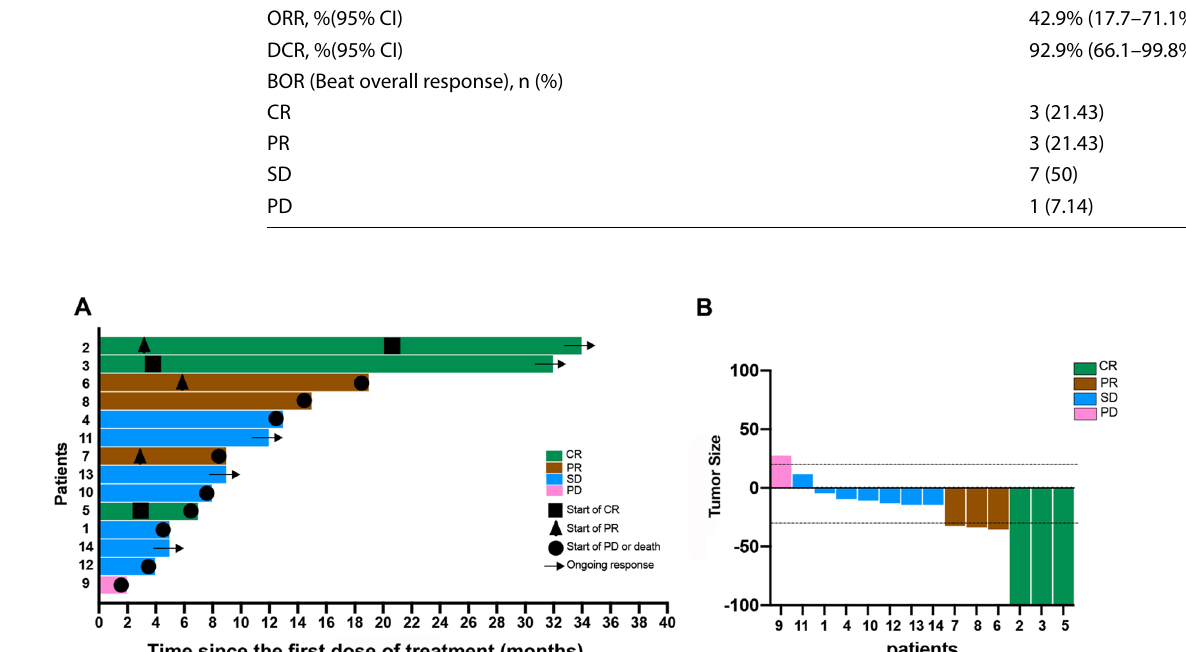
Table 6 Clinical efficacies of patients